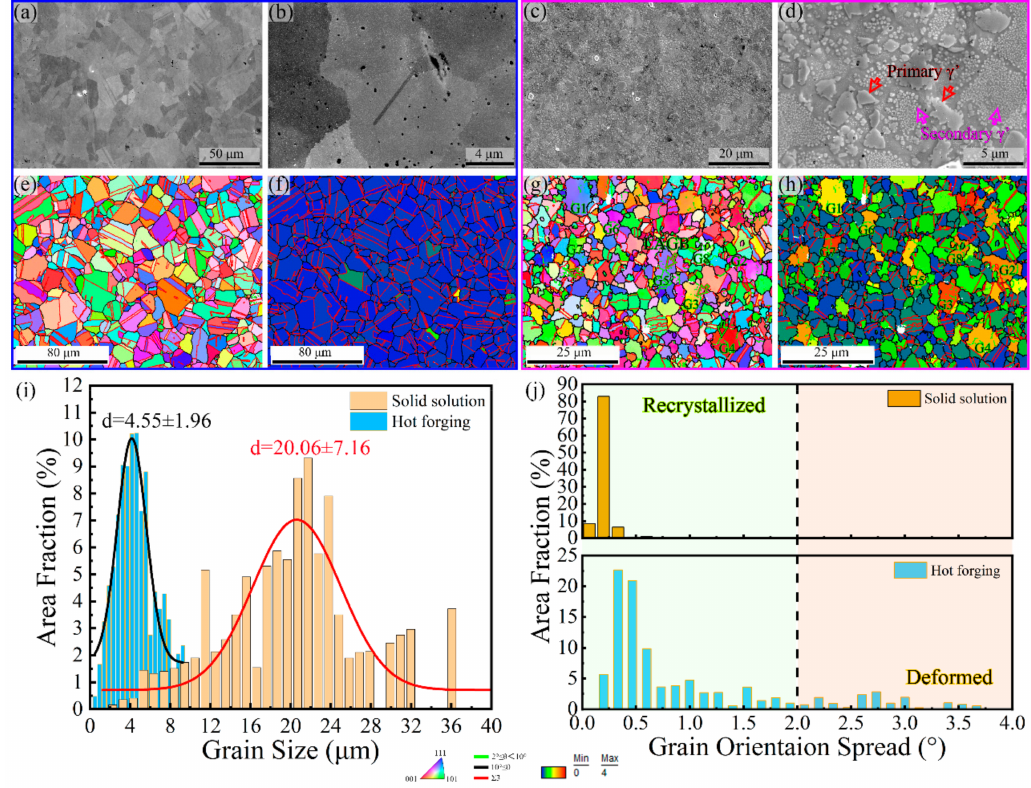
Figure 5. The microstructure characterization of the FGH96 base materials with different heat treat- ments. ( a ) Secondary electron (SE) images for solid solution (SS) treated state, and high magnification ( b ), ( c ) SE images for hot forging (HF) state, and high magnification ( d ). ( e – h ) are, respectively, the OIM map, grain orientation spread (GOS) map for SS state ( e , f ), and HF state ( g , h ). The grain size distribution ( i ) and the area fraction of grains with a specified GOS ( j ) for the two specimens are also statistically